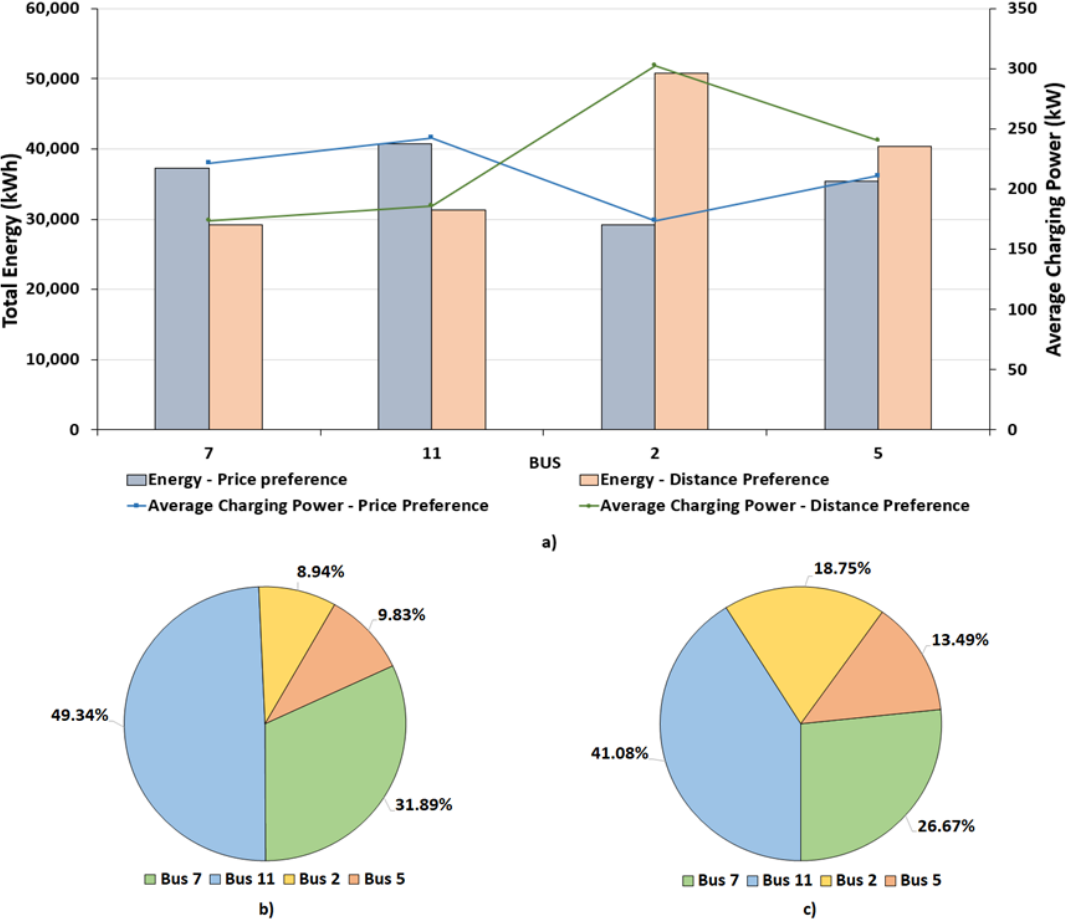
Figure 14. Energy and preference results at each bus that had parking lots at a fixed price for EV charging, with 0.20 e /kWh for slow charging and 0.30 e /kWh for fast charging. ( a ) Energy and average charging power in each EV parking lot bus. ( b ) Preference percentage for each parking lot bus considering the user price preference scenario. ( c ) Preference percentage for each parking lot bus considering the user distance preference